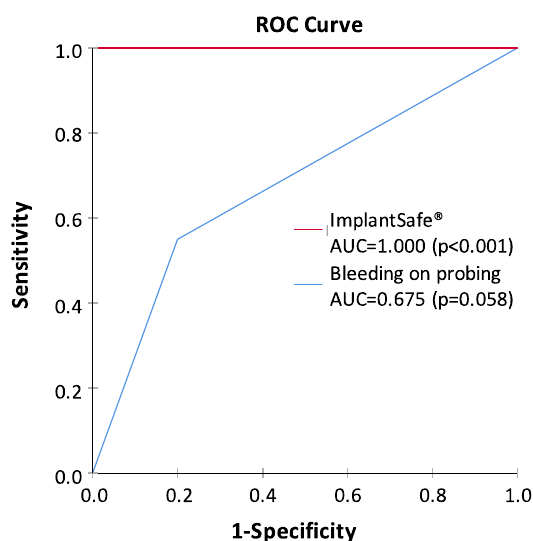
Figure 3. Receiver operating characteristic (ROC) curves and the area under the ROC curve (AUC) values for the ImplantSafe ® / aMMP-8 point-of-care test and bleeding on probing (at least one site bleeding around dental implant), representing the ability of both tests to classify peri-implantitis and health. Peri-implantitis patients (n = 20) and healthy controls (n = 20) were characterized clinically and from X-rays as described earlier [10]. The study was conducted in accordance with the Declaration of Helsinki; participants provided written, informed consent; and the protocol was approved by the local ethical committee of Stockholm Community, Sweden (2016-08-24 / 2016 / 1:8 and 2016-1-24; Dnr 2016 / 1410-31 / 1) and the Helsinki University Central Hospital, Finland (2019-6-26; Dnr HUS / 1271 / 2019).